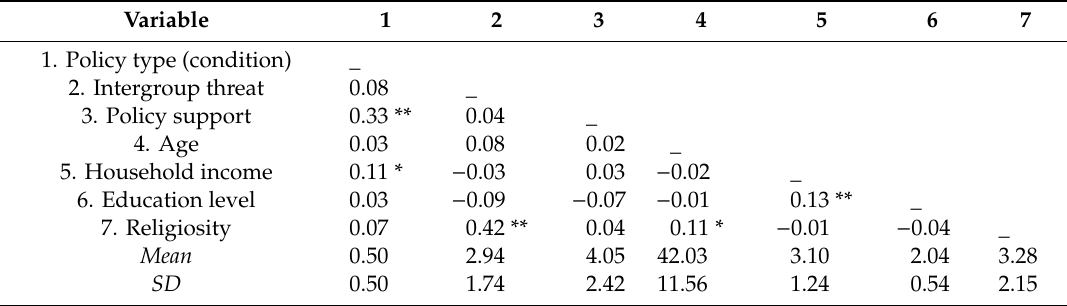
Table 2. Intercorrelations, means, and standard deviations for heterosexual cisgender women ( N = 440). Variable 1 2 3 4